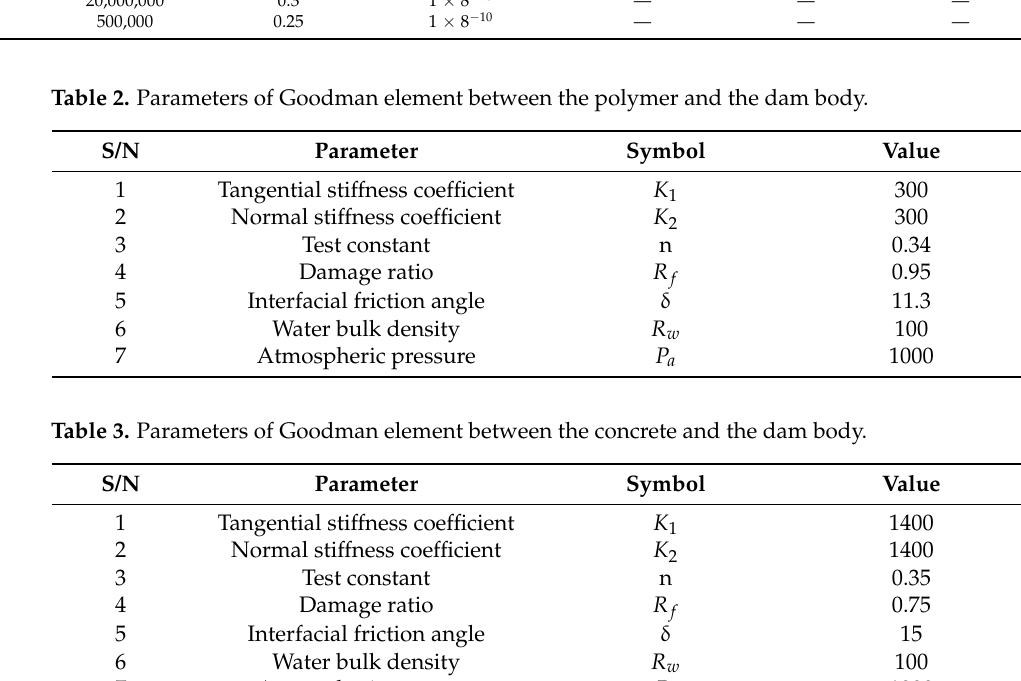
Figure 2. Schematic diagram of coordinate system and model dimensions.